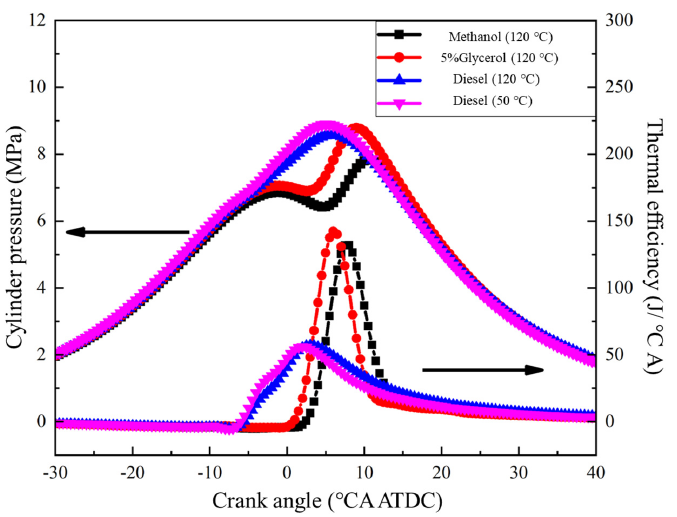
Figure 7. In-cylinder pressure and thermal efficiency under different crankshaft rotation angles.